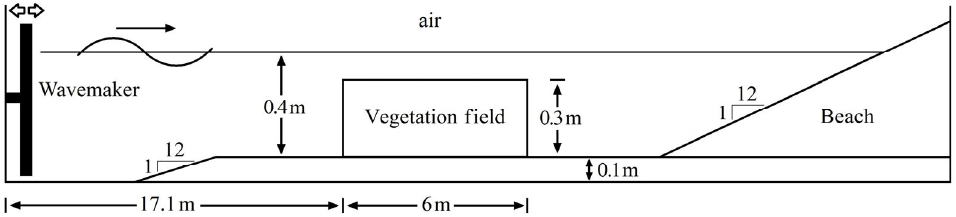
Figure 2. Experimental setup replicated for the validation of the numerical model. Note that the axes are not in scale for clarity of the exposition.